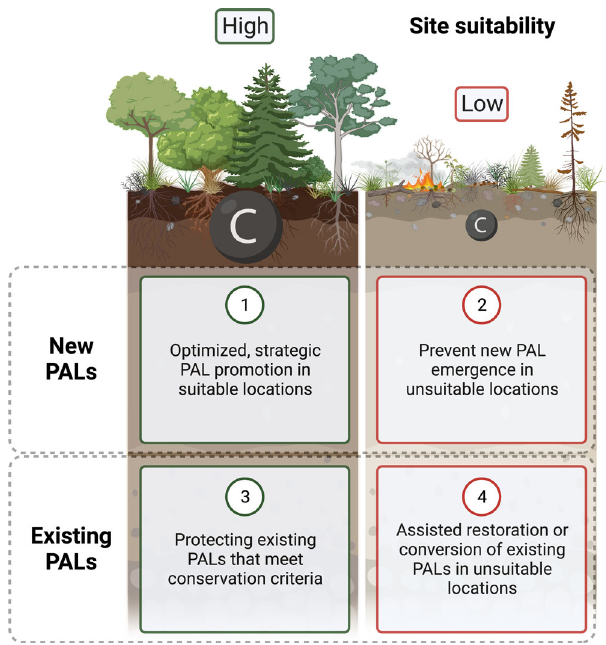
Fig.2|Thesuitabilityofanagriculturalsitewilldetermineifandhowitshould be managed as a recarbonizing post-agricultural landscape (PAL). New and existing PALs can have a high or low potential for soil and ecosystem carbon (C) sequestration and high or low feasibility when considering various competing needs(e.g.,foodproduction),trade-offs(e.g.,wild fi rerisk),andcon fl icts(e.g.,local land rights). Depending on the carbon data available, the de fi nitions used, and the land use factors considered, possible land management trajectories include (1) implementing or (2) preventing new PALs and (3) protecting or (4) restoring or convertingexistingPALsintomoreappropriatelanduses.Increasedtemporaldata and improved spatial estimates of PALs will support decision-makers in navigating scenarios like these. This graphic was created with